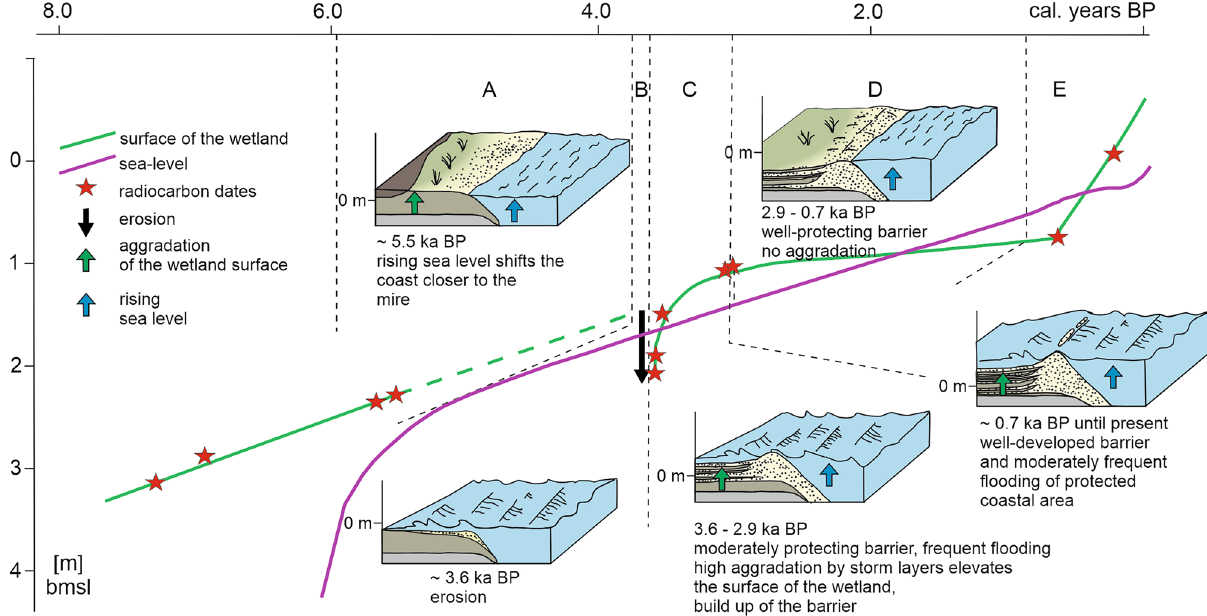
Figure 5. Sea level and coastal landform development reconstruction. Sections A to E depict discrete time spans represented schematically within the block-diagrams. The depths of age dating points indicated on the curve are corrected for mechanical and natural compaction. Figure was created with CorelDRAW Graphics Suite 2019 (Corel Corporation: https:// www. corel. com/ en/ old- versi ons/ corel draw-